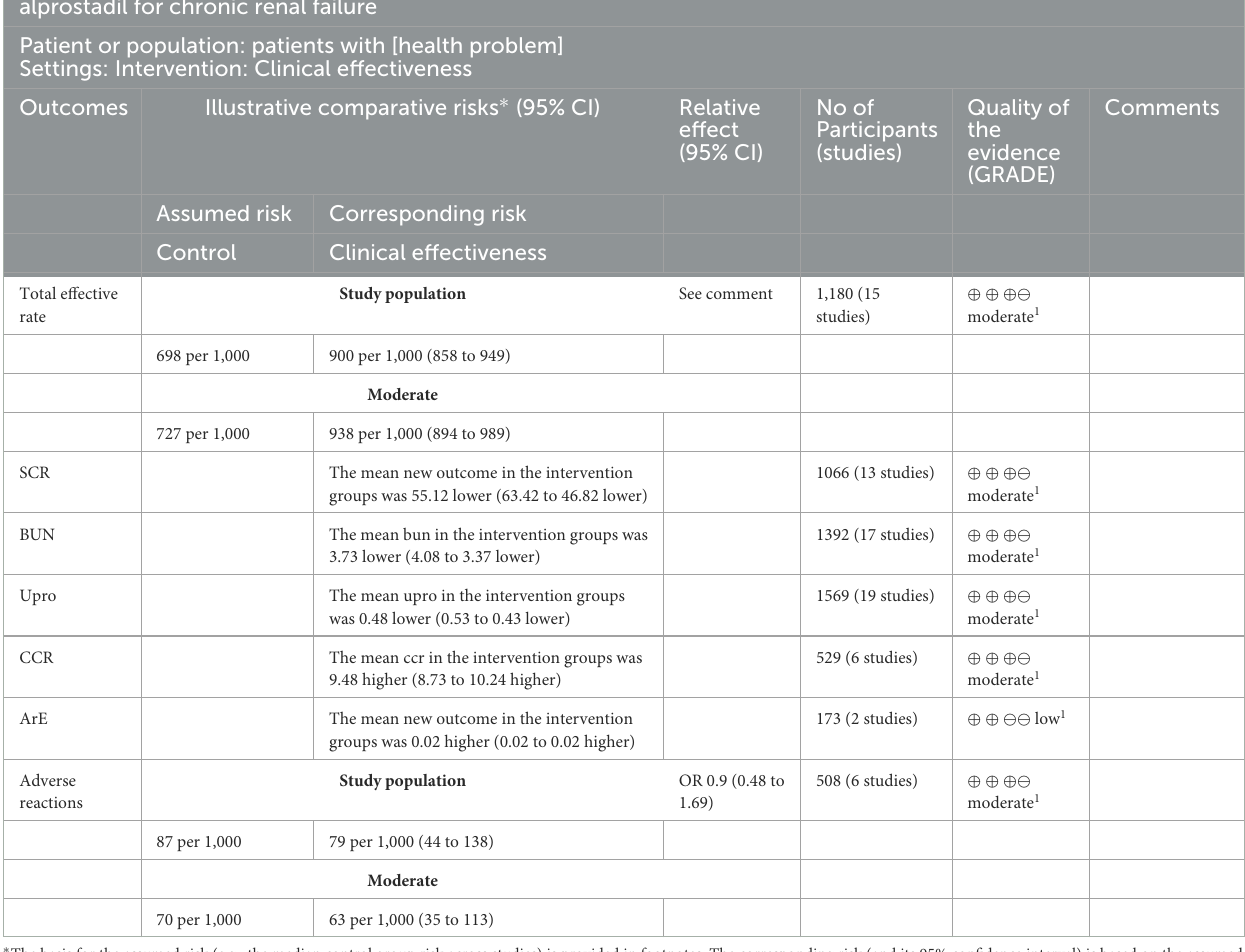
TABLE 2 Outcome index GRADE evidence quality evaluation. Shenkang injection combined with alprostadil compared to alprostadil for chronic renal failure Patient or population: patients with [health problem] Settings: Intervention: Clinical